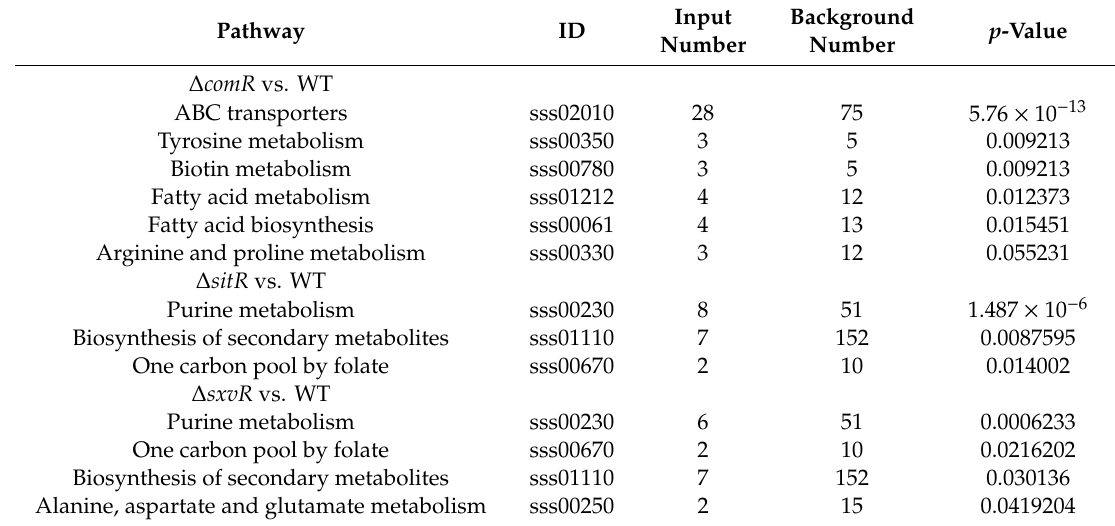
Table 1. Pathways repressed in the ∆ comR